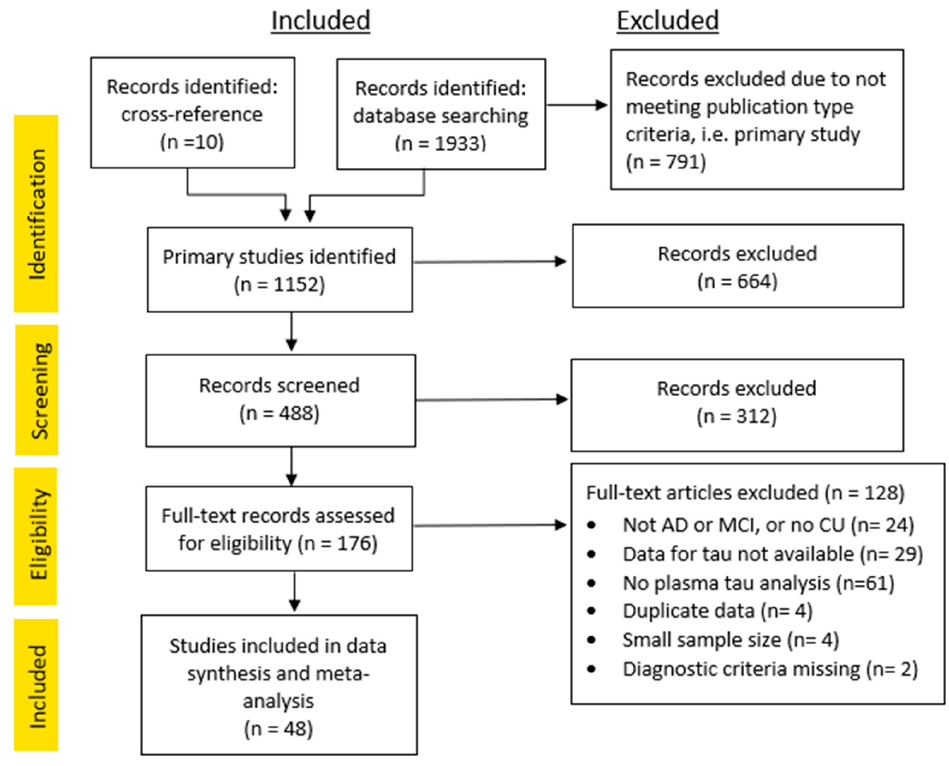
Figure 1. Study inclusion fl ow diagram.